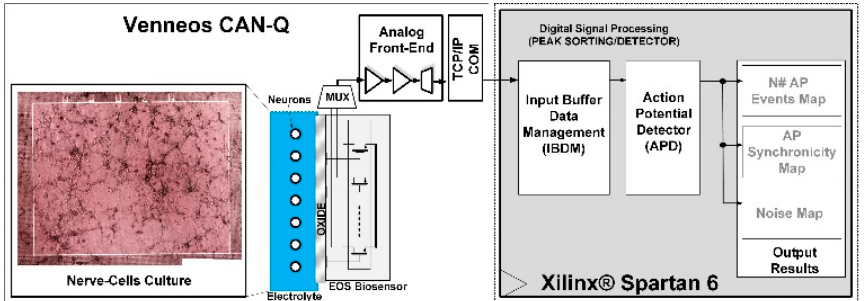
Figure 1. Neuronal-cells culture experimental setup [3] .